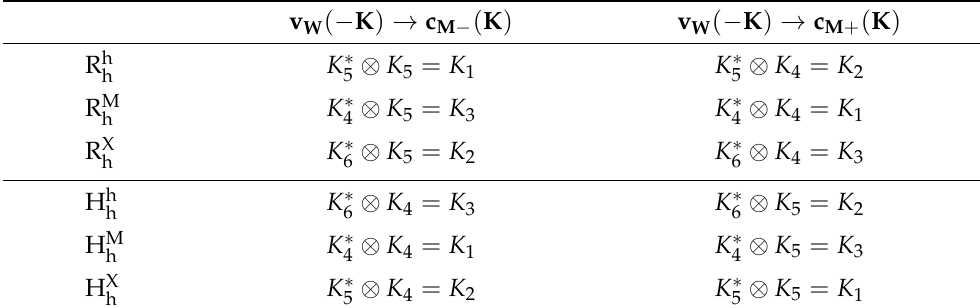
Table 6. Direct product of valence bands at the − K point and conduction bands at the K point in the C 3 symmetry